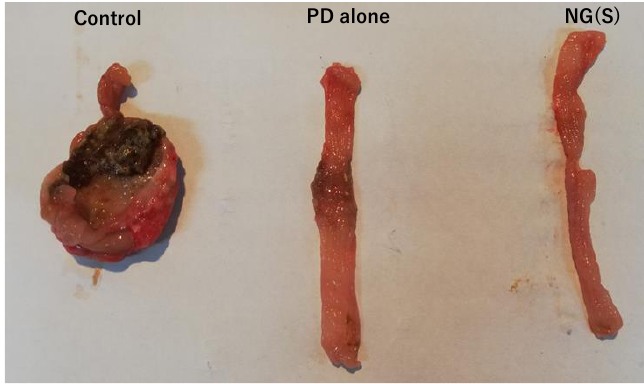
Figure 12. Representative images of distal colon on the assessment day at 10 mg PD eq./kg.